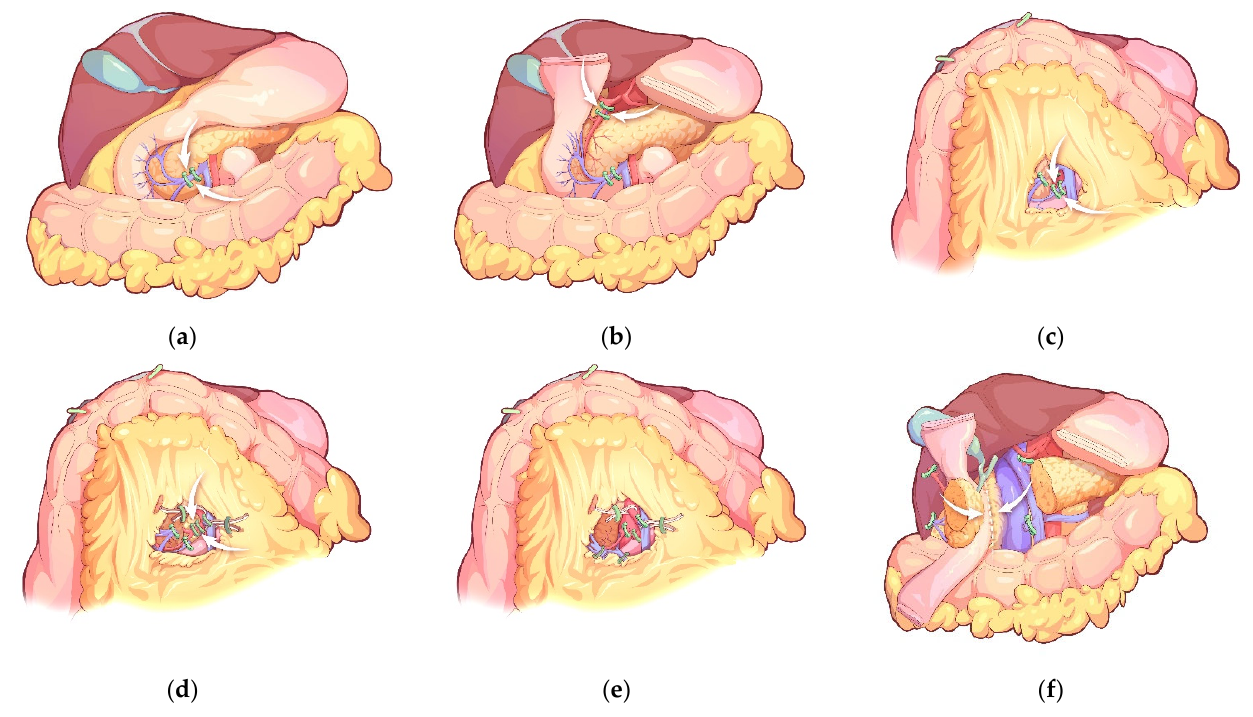
Figure 1. The main surgical procedures of no-touch pancreaticoduodenectomy: ( a ). Ligation of the right gastroepiploic vein and Henle’s trunk; ( b ). Ligation of the gastroduodenal artery; ( c ). Ligation of the inferior pancreaticoduodenal vein; ( d ). Ligation of the inferior pancreaticoduodenal artery; ( e ). Complete clearance of all tissues located around 180 degrees to the right of the superior mesenteric artery; ( f ). Complete the resection of the posterior peritoneum of the duodenum and pancreatic head by a reversed Kocher’s maneuver.